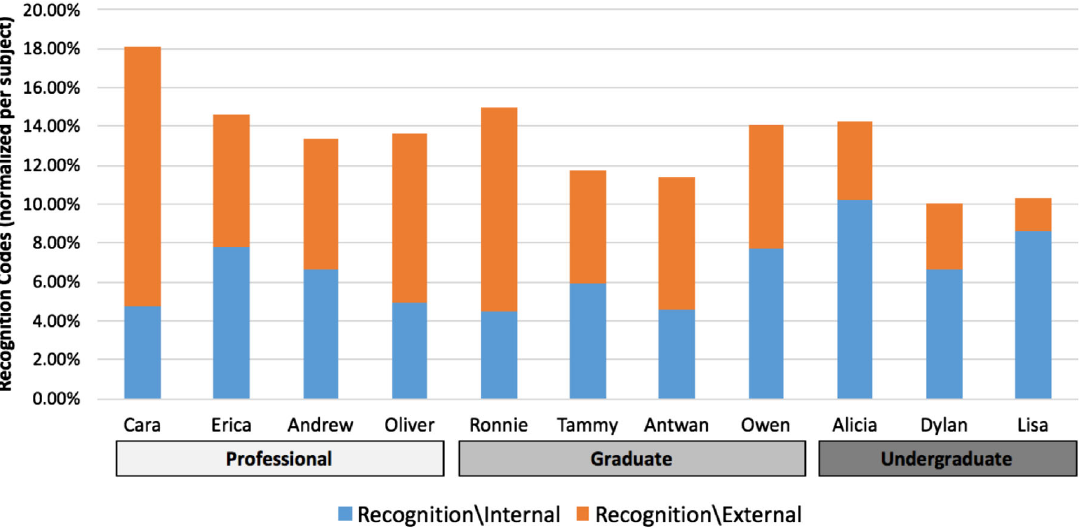
FIG. 4. Breakdown of internal and external recognition codes for participants based on their career position. The counts are normalized to the total code counts for each individual interview. The blue parts of the bar represent internal recognition percentages, and orange parts of the bar represent the external recognition